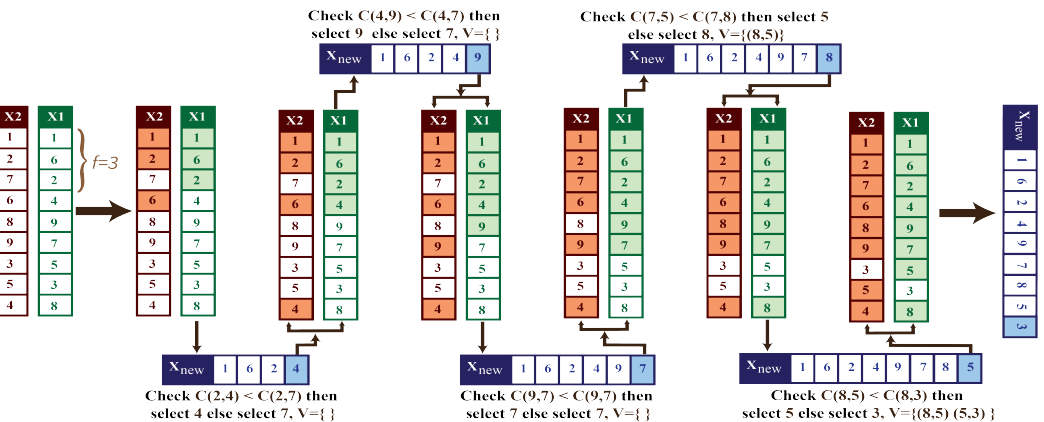
Figure 4. Two-exchange crossover algorithm for D-collector path